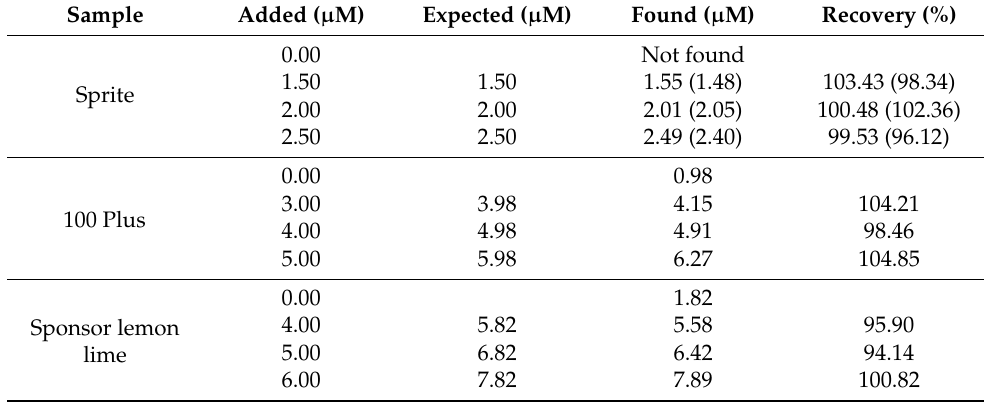
Table 6. Performance of modified sensor for tartrazine determination in real